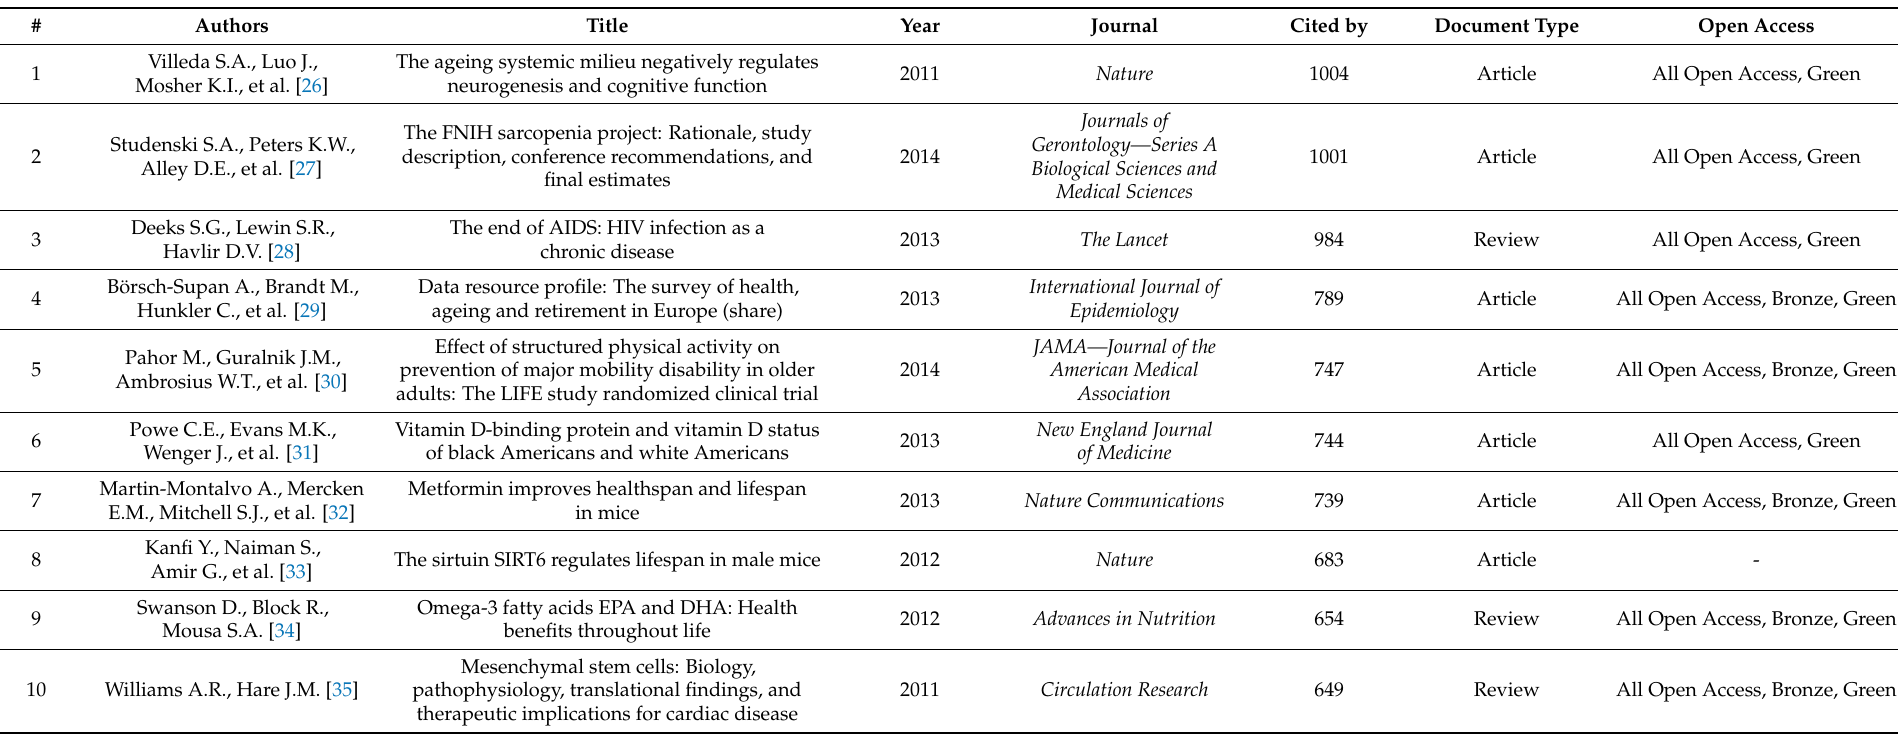
Table 1. The top ten most cited publications on the topic of “healthy aging” according to Scopus (2011–2020) and ordered from most to least